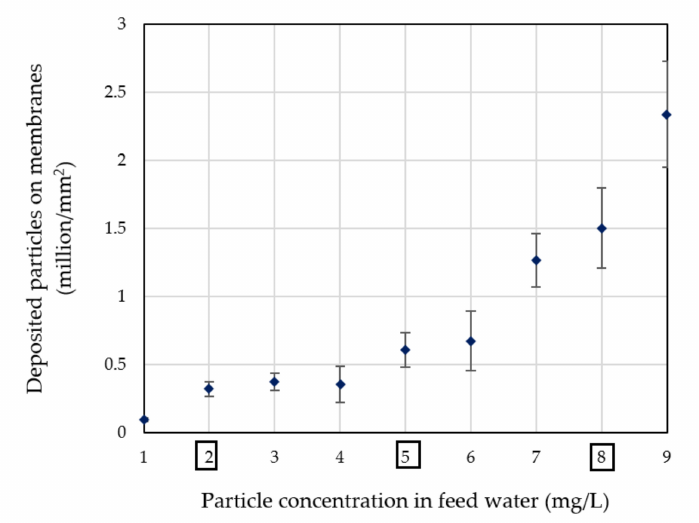
Figure 9. Mean number of particles for 1–9 mg / L feed water particles concentrations detected per mm 2 membrane area on equalized SEM photos of PVDF flat sheet membranes (n = 120 for each particle concentration, 1280 × 960 pixels, 1500 × , 10 kV, Keyence VE-8800).